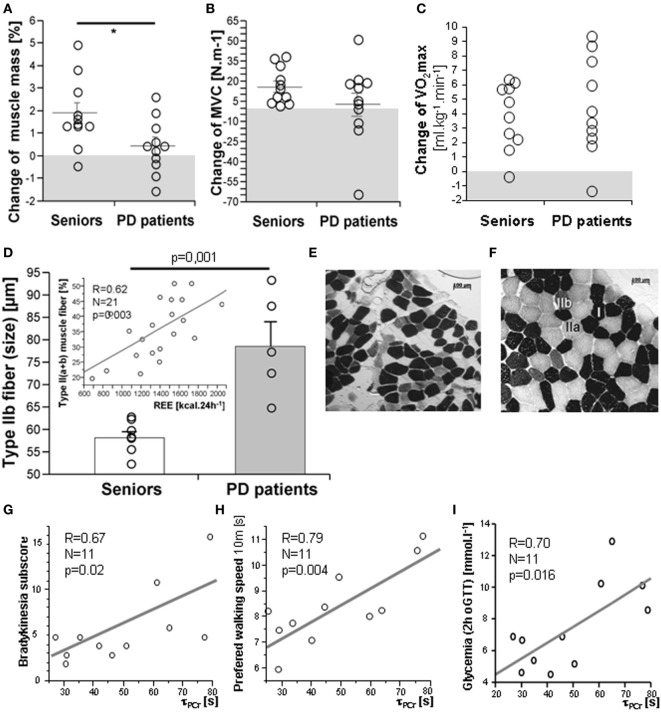
Exercise intervention-induced changes in muscle mass (A), strength (B), and VO2max (C). The muscle of PD patients exhibited type IIb fiber hypertrophy (D,E,F) and a proportion of type II fibers was associated with resting energy expenditure (REE), [(D)-insert], cross-sectional microscopic image of skeletal muscle (m. vastus lateralis) from a healthy senior (E) and a PD patient (F); Time constant for muscle postexercise phosphocreatine (PCr) recovery (τPCr) was positively associated with the bradykinesia disability score (G), time in the walking test (H), and with 2-h glycemia (I). Data are expressed as average ± SEM, *p < 0.05, †p < 0.1; MVC, maximal voluntary contraction force. Type I, IIa, and IIb muscle fibers are identified by different ATPase staining intensity.